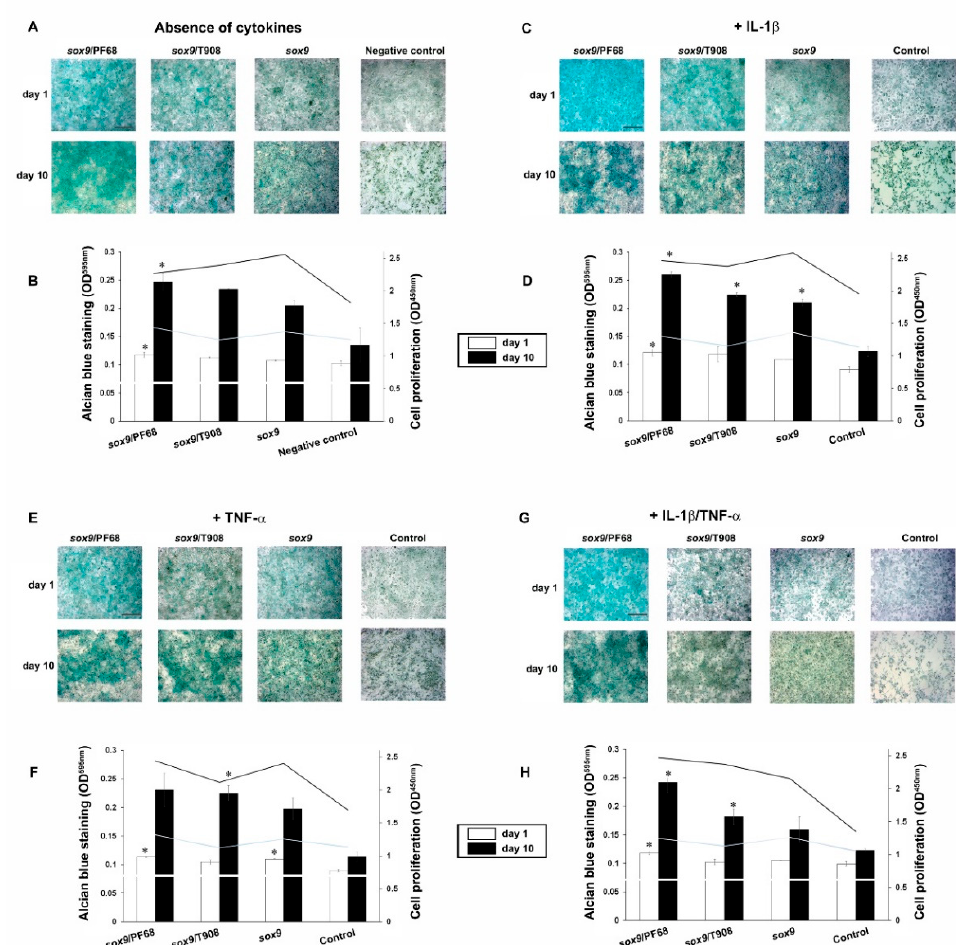
Figure 3. Biosynthetic activities in rAAV-FLAG-h sox9 -transduced human OA chondrocytes using polymeric micelles. Cells in monolayer culture were directly transduced with the rAAV / polymeric micelles ( A , B ) or after pre-incubation for 4 h with IL-1 β (10 ng / mL) ( C , D ), TNF- α (100 ng / mL) ( E , F ), or IL-1 β / TNF- α (10 / 100 ng / mL) ( G , H ), as described in Figures 1 and 2 and in the Materials and Methods. The cultures were processed at the denoted time points for Alcian blue staining (magnification x10, scale bar 200 µ m; all representative data) ( A , C , E , G ) with spectrophotometric evaluations for cell proliferation and proteoglycan deposition following solubilization in 6 M guanidine hydrochloride ( B , D , F , H ), as described in the Materials and Methods. Control conditions included the absence of copolymer or vector treatment (negative control) and the application of free rAAV vector (positive control). * Statistically significant compared with the negative control at similar time points.